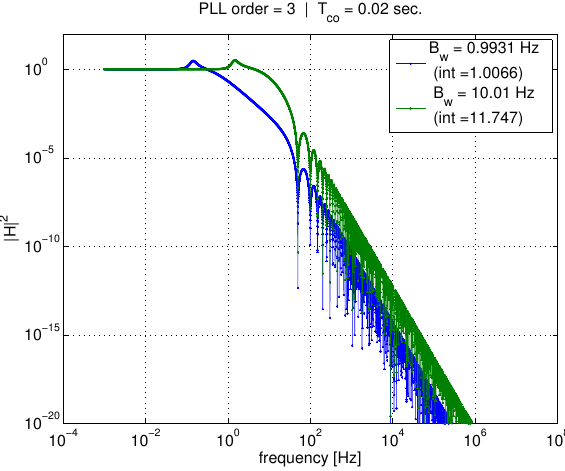
Figure 5. Effect of T co and PLL bandwidth on input–output transfer function, 20